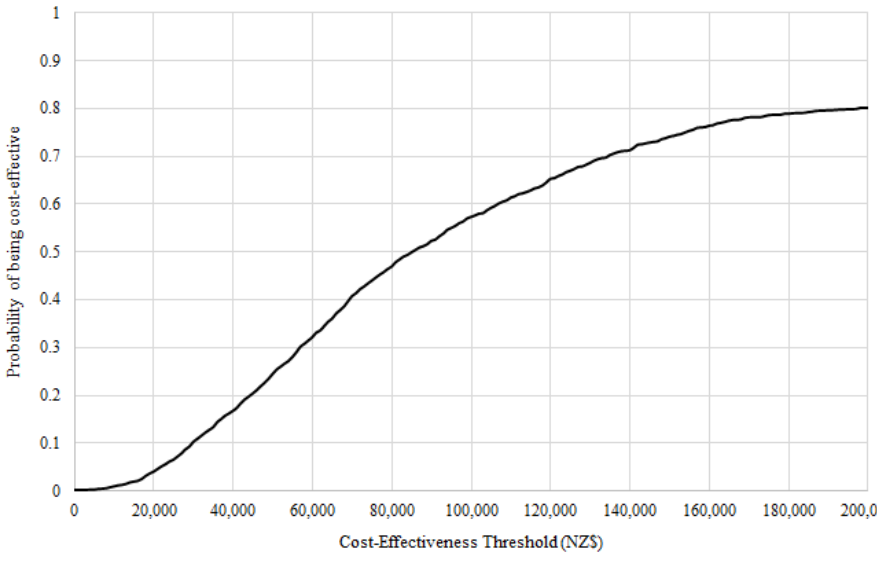
Figure 3. Probability of the modeled physical activity app promotion intervention being cost-effective for different cost-effectiveness thresholds (in cost per quality-adjusted life year